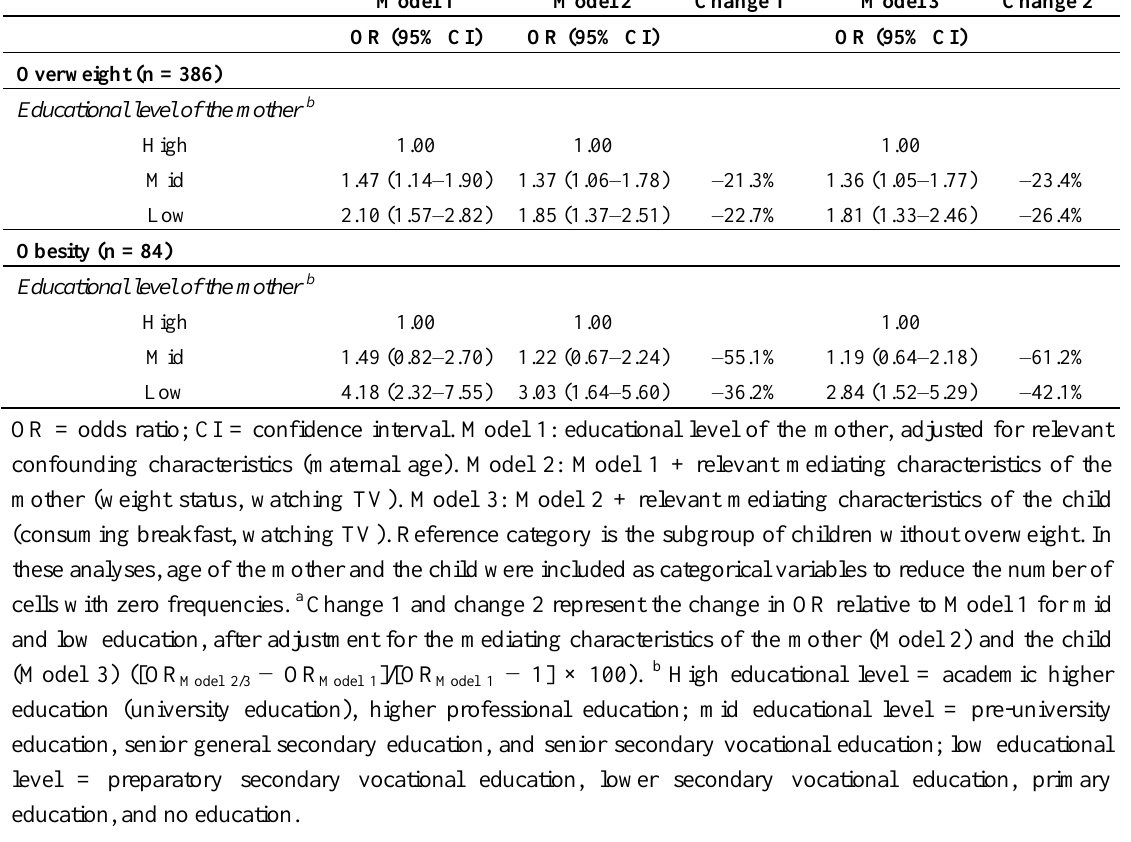
Table 3. Multinomial logistic regression analyses for the association between maternal educational level and children’s weight status (n = 5,582). Model 1 Model 2 Change 1